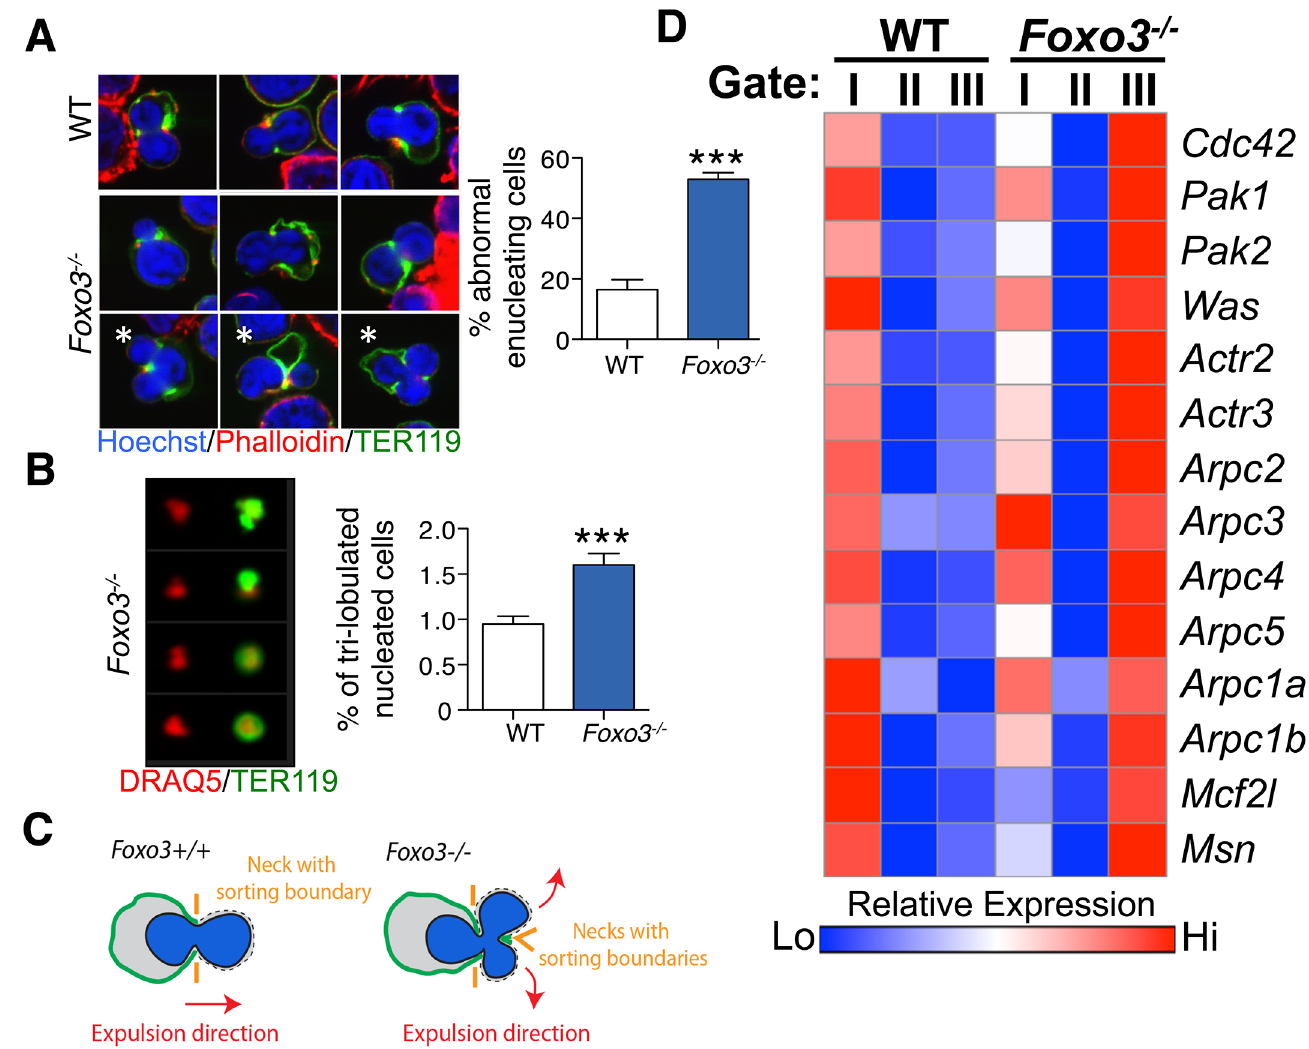
Fig 6. Defective enucleation in Foxo3 -/- bone marrow erythroblasts. (A) Enucleation was analyzed by immunofluorescence of freshly isolated bone marrow cells from WT (n = 5) and Foxo3 -/- (n = 3) mice using anti-TER119 antibody (green), Rhodamine Phalloidin (red) and Hoechst (blue). Images were obtained by confocal microscopy and abnormal enucleating cells counted. Representative images of enucleating cells are shown, with white asterisks denoting abnormally enucleating cells. At least 10 enucleating cells were counted per bone marrow and the results indicate the percentage of abnormal enucleating cells in each bone marrow as mean ± SEM. (B) Quantification of abnormal nuclei within the orthochromatic faction of WT and Foxo3 -/- erythroblasts by imaging flow cytometry. Abnormal nuclei were defined as having high 3-fold symmetry of the nucleus [64]. Representative images of normal and abnormal nuclei from Foxo3 mutants are shown are shown. Results are mean ± SEM of n = 4. * P < 0.05 ** P < 0.01 *** P < 0.001, Student ’ s t test. (C) Model for the impact of loss of FOXO3 on the enucleation process. (D) Heatmap of RNA-Seq data of CDC42-related gene cluster (both upstream and downstream of CDC42) implicated in polarity and actin polymerization in Gates I-II and III of Foxo3 wild type and mutant